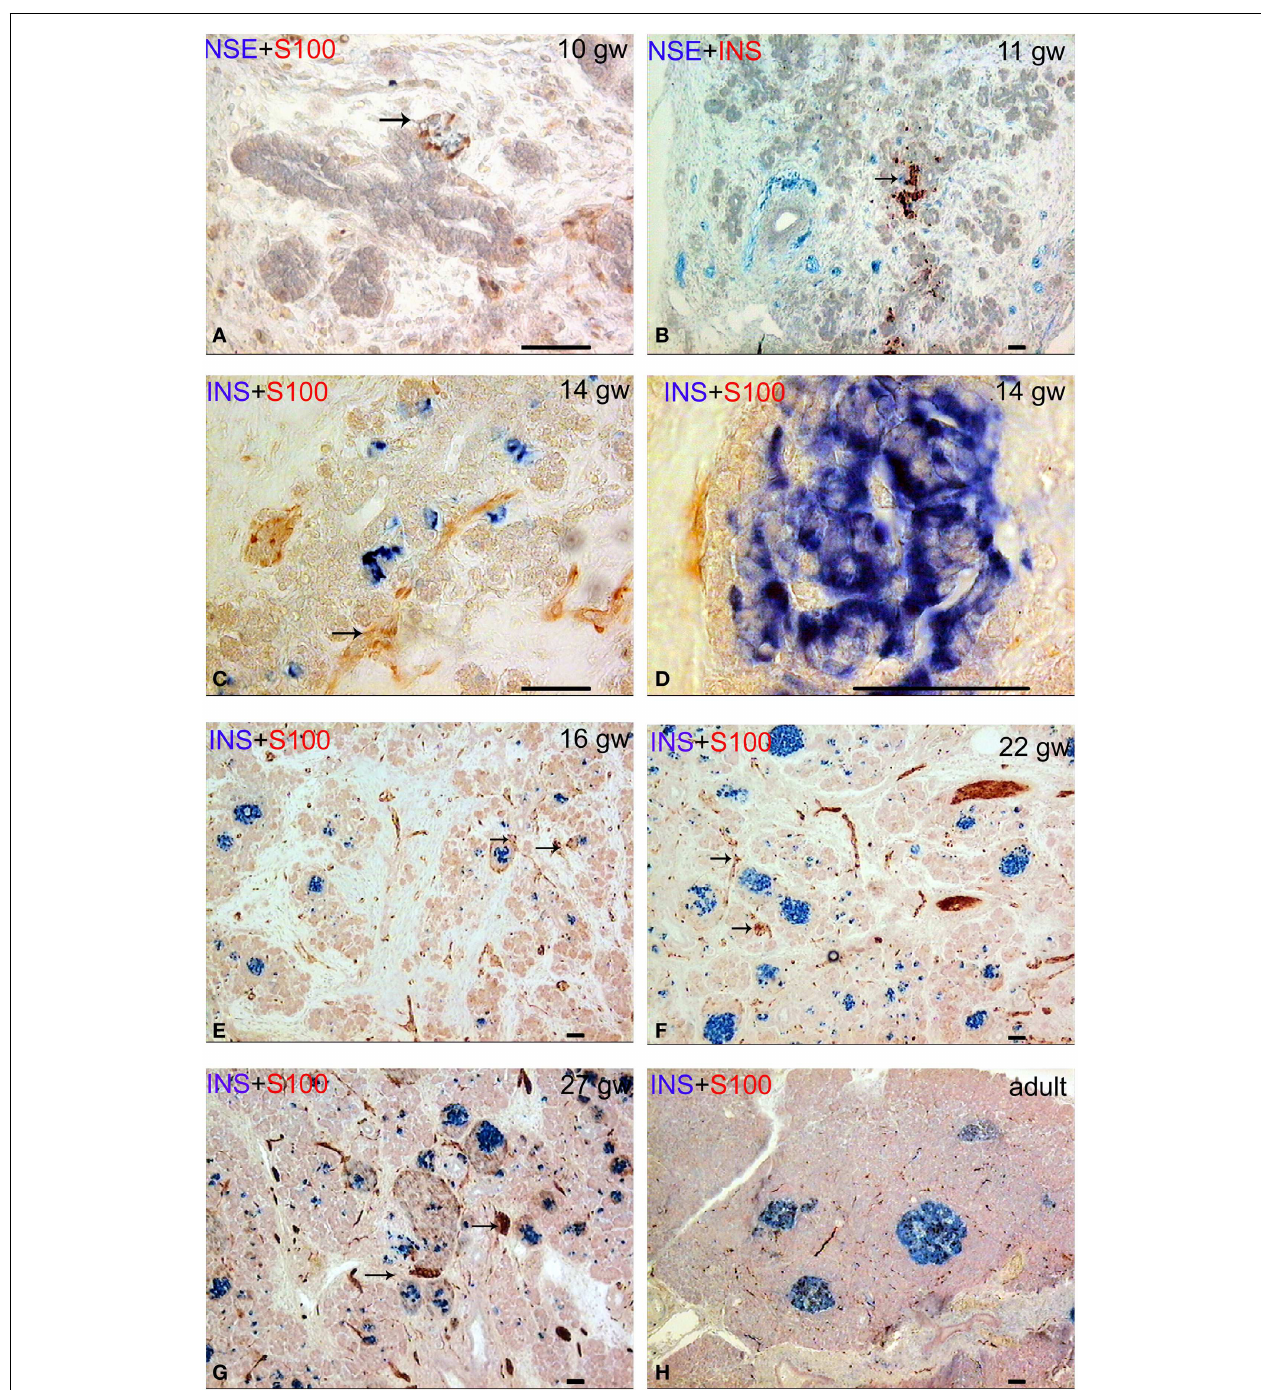
some nerve fibers are passing between two nerve ganglia. Insulin (blue) and S-100 (red) double staining. (D) The close proximity of the fine nerve fiber and a Langerhans’ islet at gw 14. Insulin (blue) and S-100 (red) double staining. (E–G) The consequent increase of pancreatic innervation in early and middle fetal periods. Insulin (blue) and S-100 (red) double staining. (H) Innervation of the adult pancreas. Insulin (blue) and S-100 (red) double